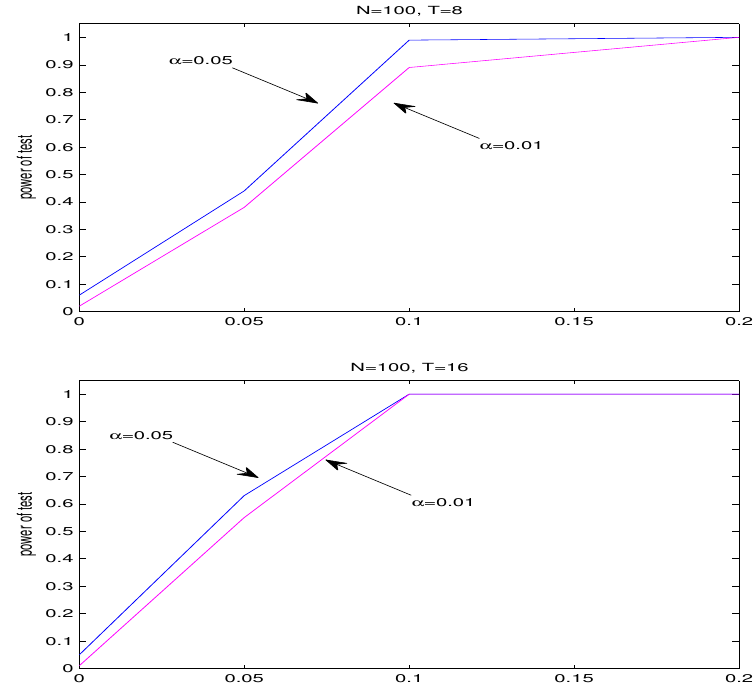
Figure 4. Powers of the test with α = 0.01 and 0.05, respectively, with sample size N ∗ T .